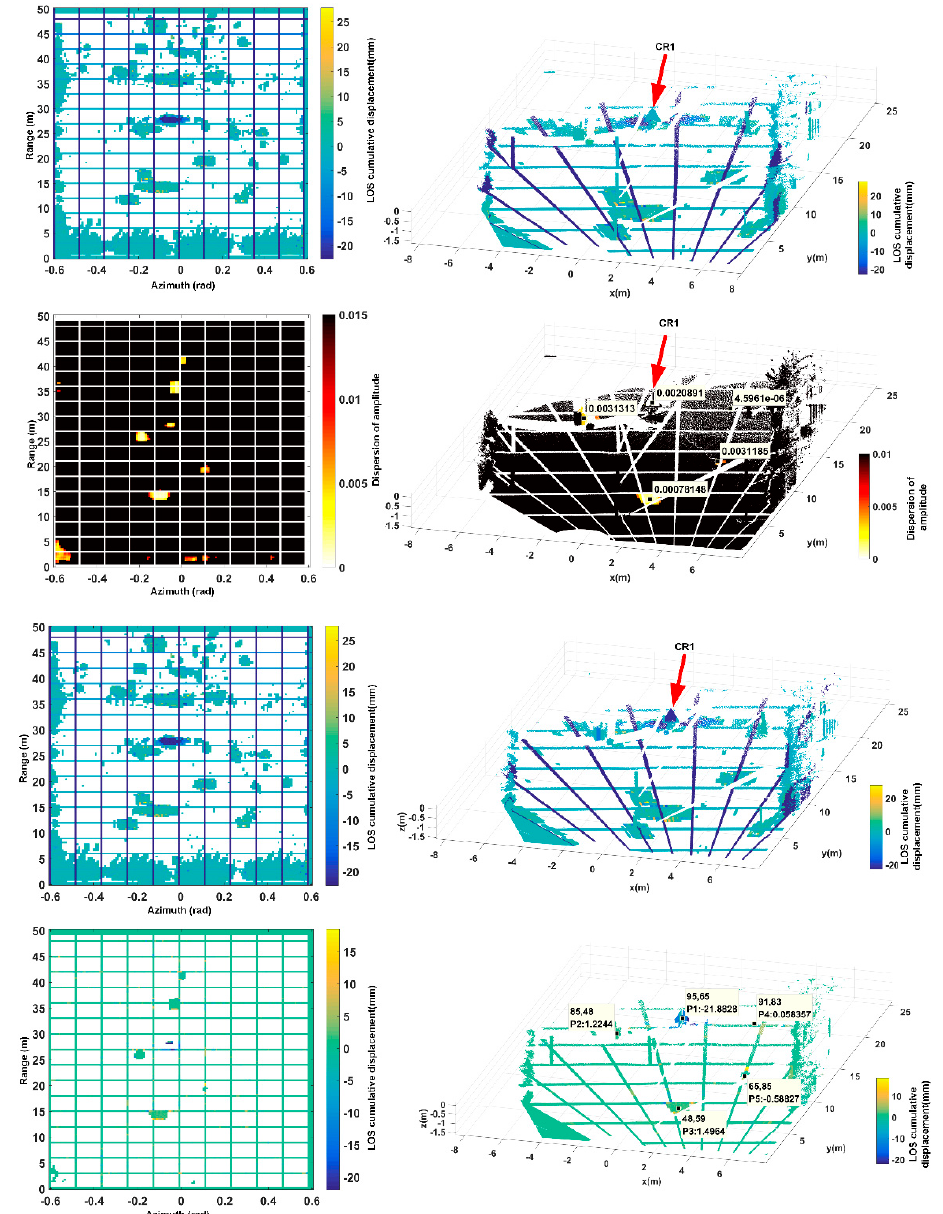
Figure 19. In the first line, two figures show the 2D displacement map and 3D mapping grid relationship, but the 3D mapping result is not corrected. And in the second line, the two figures show the DA 3D mapping, and the pixels whose DA are less than the threshold of DA < 0.01 are shown. In the third line, two figures show the corrected 3D mapping result. The last line shows only the pixels that DA < 0.01 are shown, which is used to select ground control points for atmosphere correction.